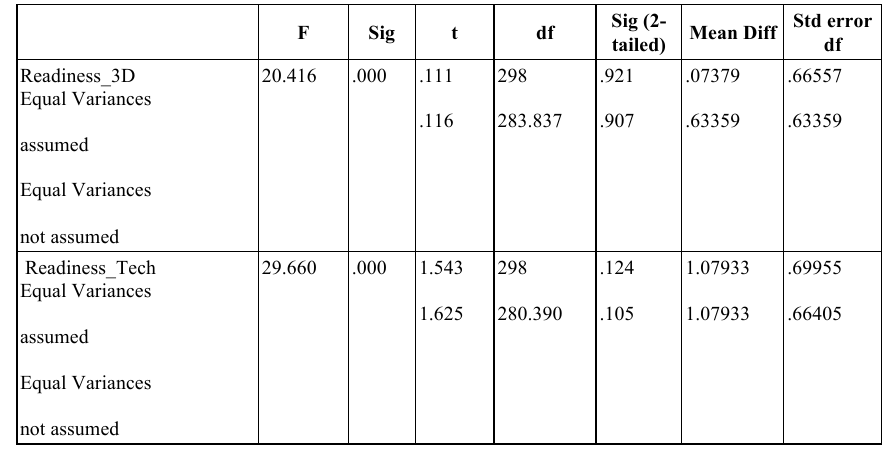
Table 5. Showing T test between gender and the